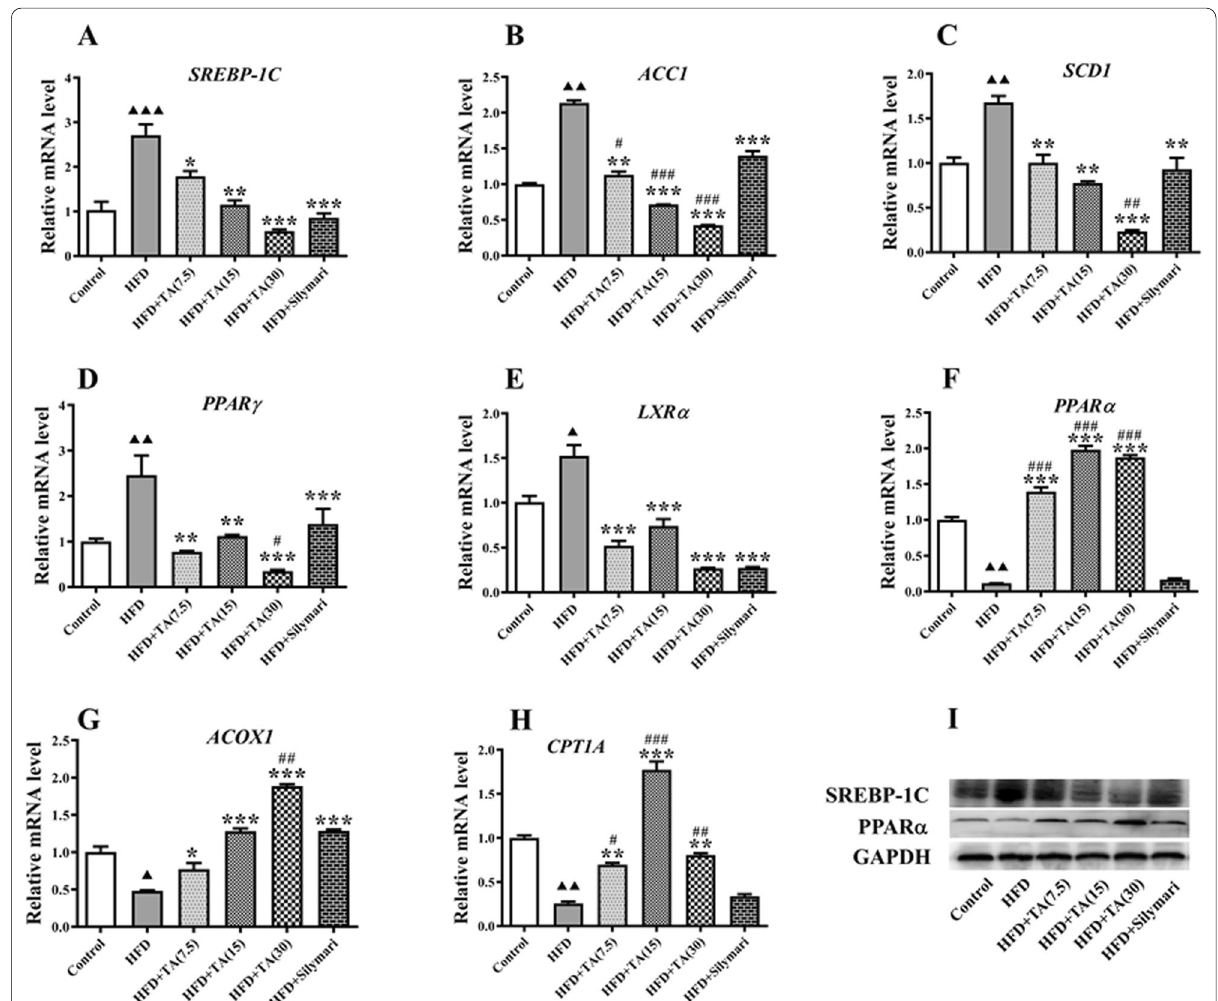
Fig. 3 Effect of TA on Lipid metabolism‑related gene and protein expressions in liver tissues of HFD‑fed mice . mRNA levels of SREBP-1C ( A ), ACC1 ( B ), SCD1 ( C ), PPARγ ( D ), LXRα ( E ), PPARα ( F ), ACOX1 ( G ), and CPT1A ( H ); I Protein expressions of SREBP-1C and PPARα . Control: mice were fed a normal diet and treated with 0.5%CMC‑Na (solvent) via gavage; HFD: mice were fed HFD; HFD HFD and treated with TA (7.5, 15, and 30 mg/kg, respectively) via gavage; HFD ▲ / ▲▲ / ▲▲▲ P < 0.05/0.01/0.001 vs. control group; */**/*** P < 0.05/0.01/0.001 vs. HFD group; #/##/### P < 0.05/0.01/0.001 vs. HFD